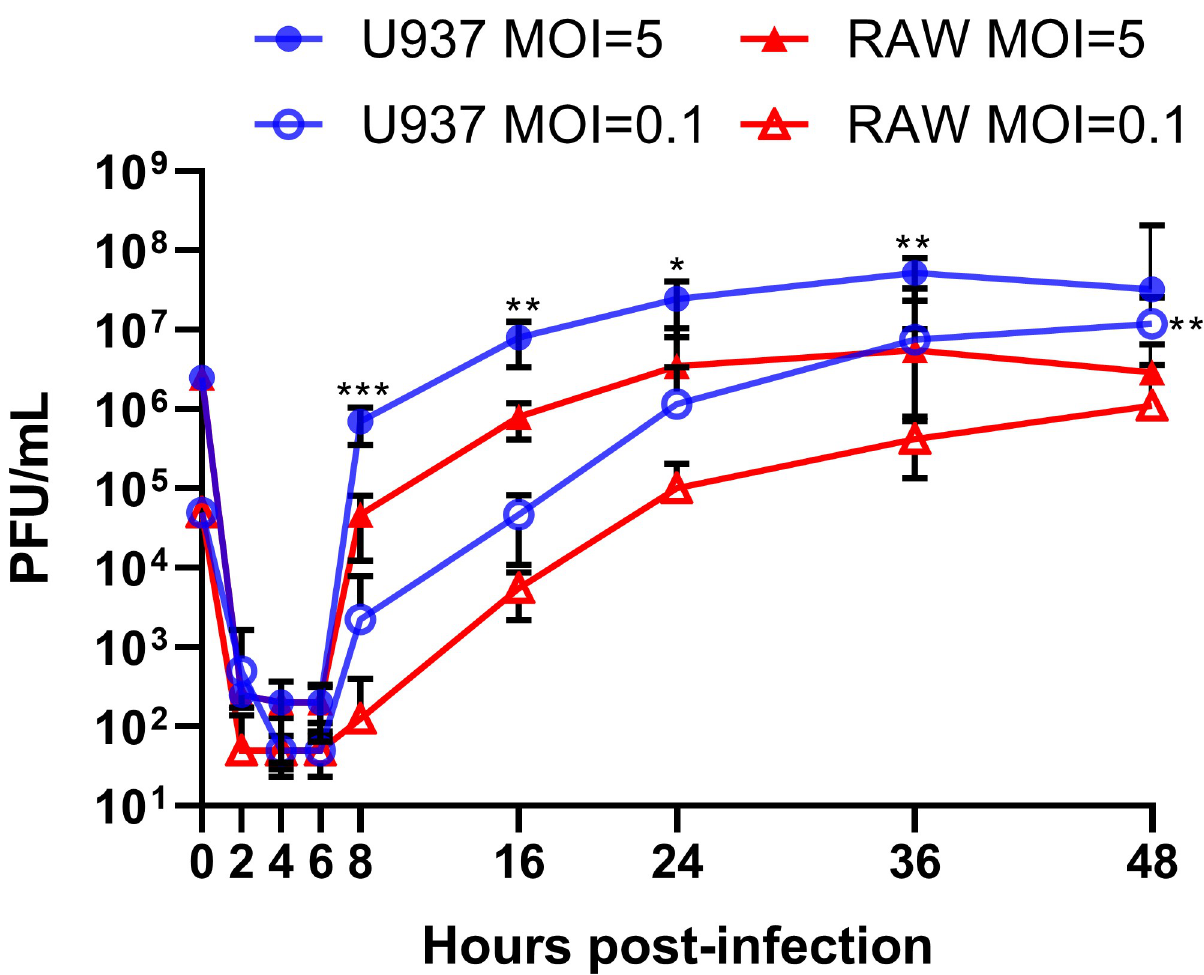
Fig 1. CHIKV replicates more efficiently in human macrophages than in murine macrophages. CHIKV infectious virus quantification was performed via plaque assay at the stated times (hpi). Data show mean values of three independent experiments with a total of n = 9, MOI = 0.1 and 5. Statistical significance was determined using multiple t-test corrected using Holm-Sidak method. � P < 0.05; �� P < 0.01; ��� P < 0.001; NS, not significant.